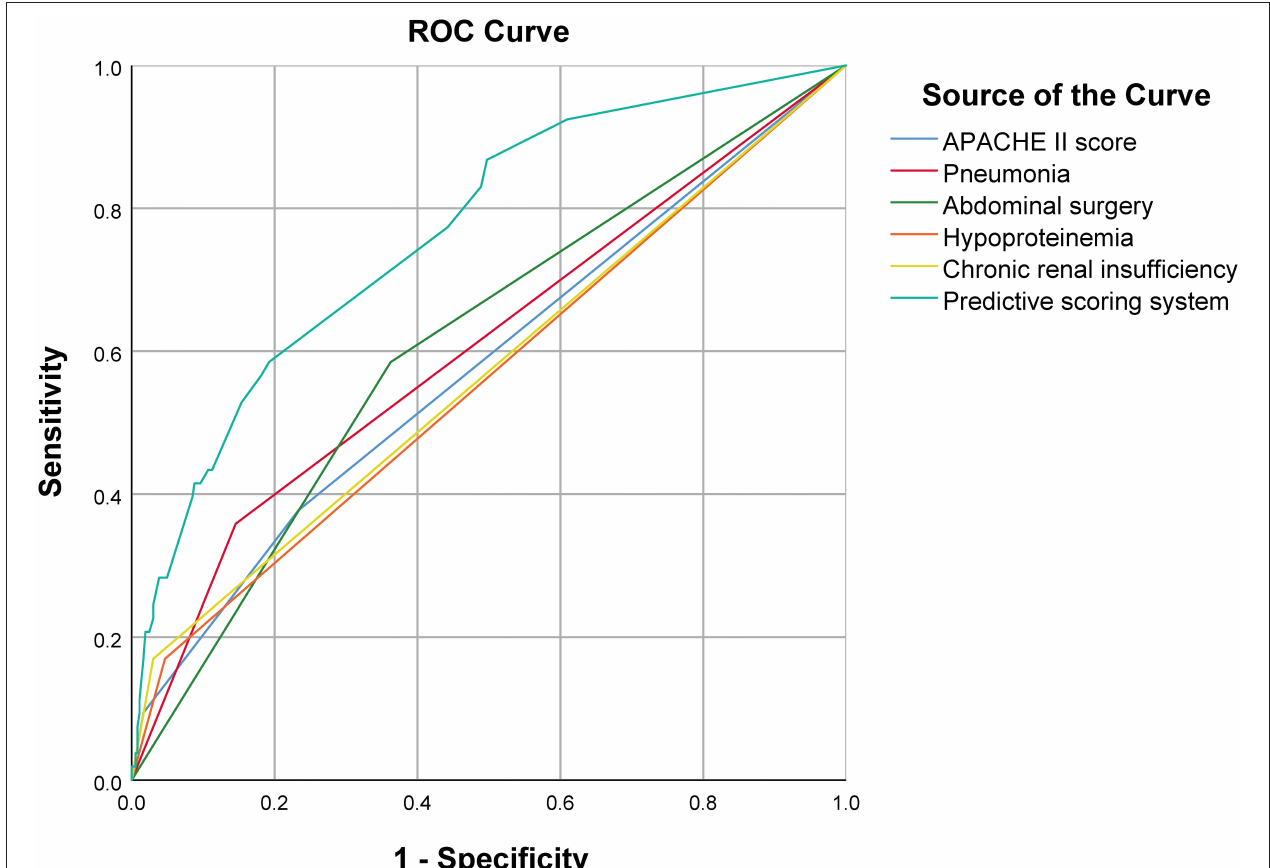
FIGURE 2 | Comparison of ROC curve between predictive scoring system and each independent risk